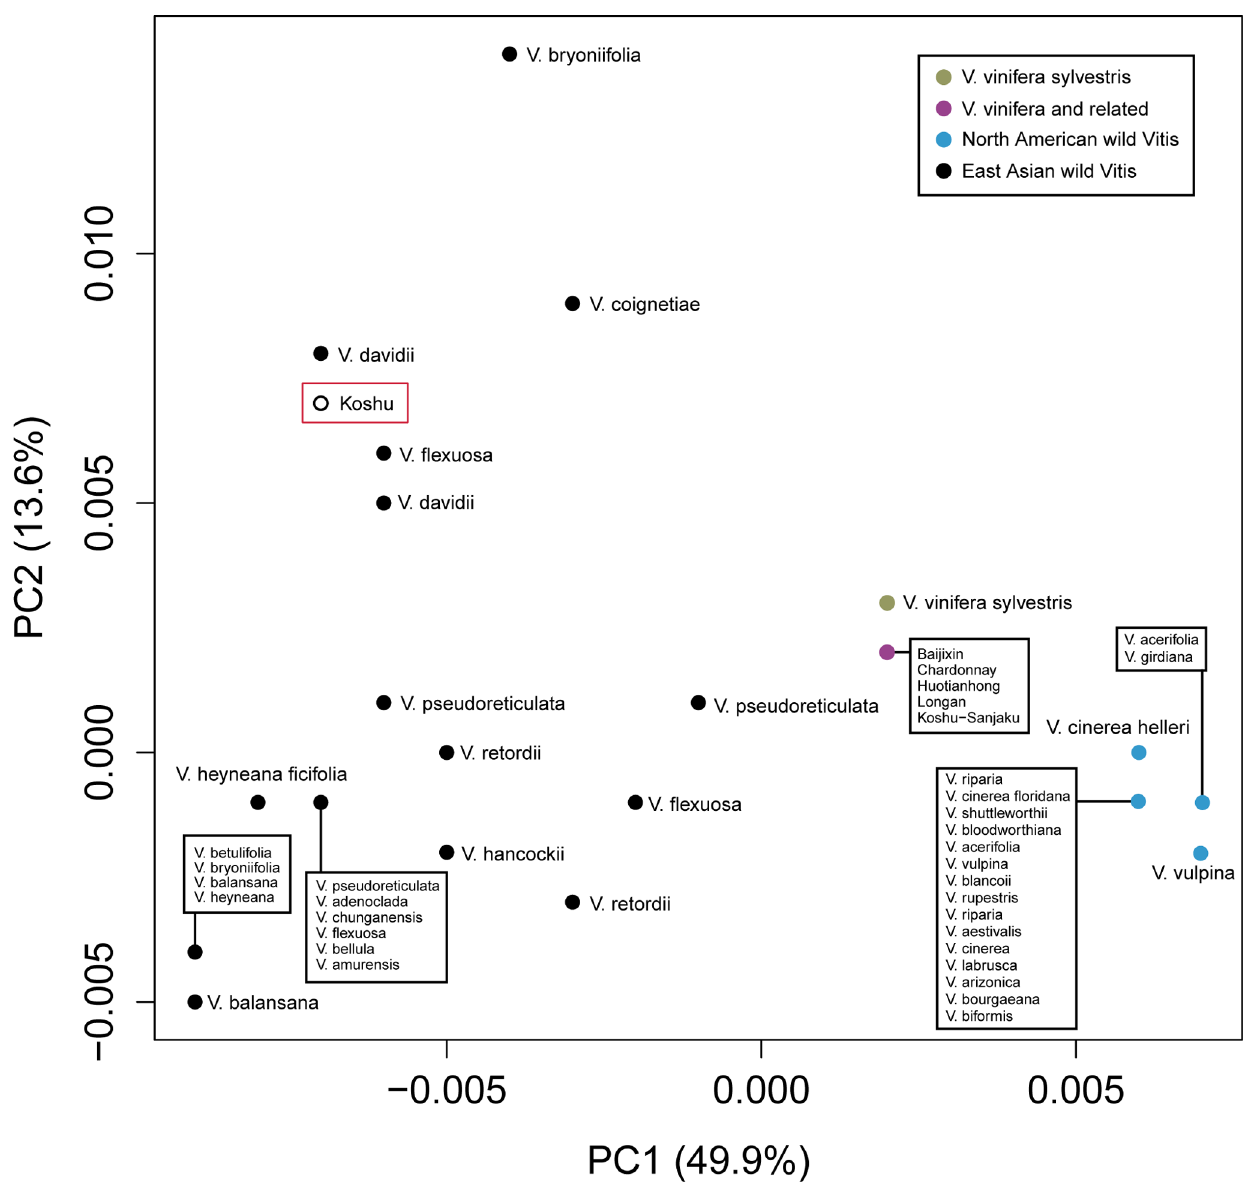
Fig 2. Principal coordinates analysis plot based on partial chloroplast sequences from diverse Vitis accessions. The proportion of variation explained by each PC is found in parantheses along each